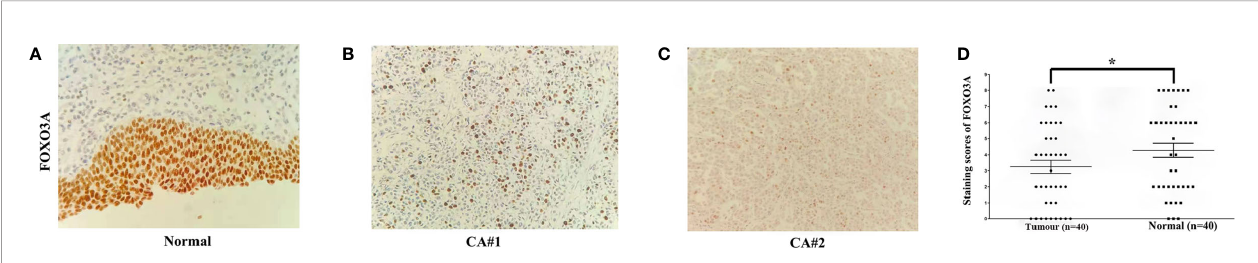
FIGURE 1 | FOXO3a expression in UTUC tissues determined by immunohistochemical staining (original magni fi cation, 200×). (A – C) Representative FOXO3a expression in tumor and normal tissues, with positive expression located in the nucleus. (D) Scatter dot plot showing the staining score (mean ± SEM) of FOXO3a in tumor and normal tissues using the paired t-test.